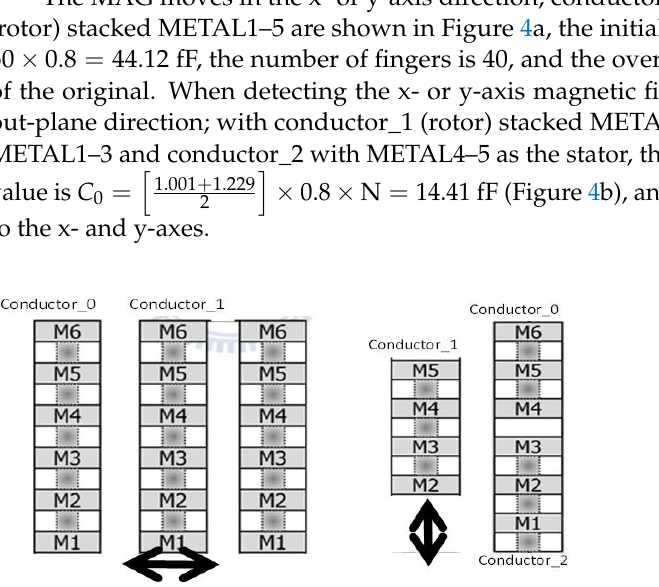
Figure 3. Magnetometer shows plane motion direction for detecting ( a ) y-axis, ( b ) x-axis, and ( c ) z-axis.